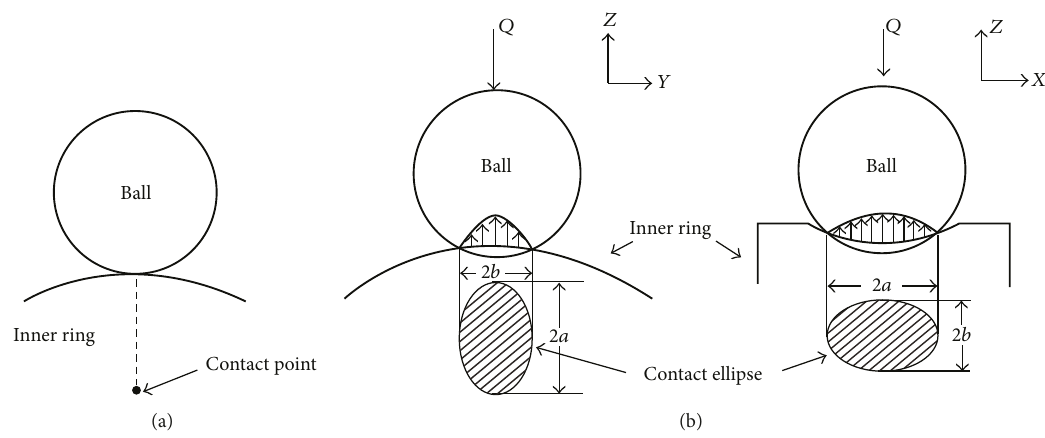
Figure 4: The contact area between the ball and raceway. (a) The contact point under no load conditions; (b) the contact ellipse under an applied load [18].